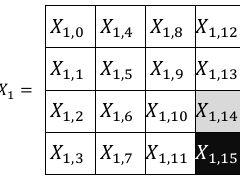
Figure 5: Input to the first round of AES